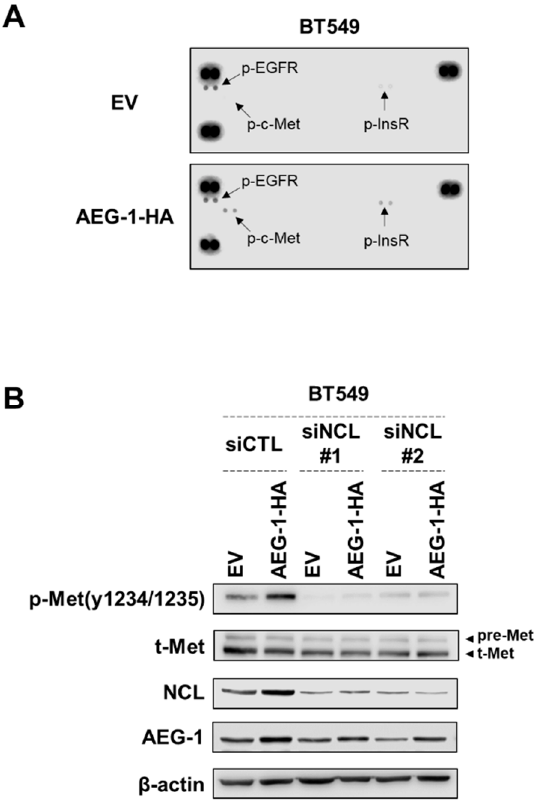
Figure 4. AEG-1 promotes c-Met activating tyrosine phosphorylation and NCL knockdown reduces AEG-1-induced c-Met activation in breast cancer cells. ( A ) BT549 cells were transfected with the AEG-1-HA or empty vector (EV) plasmids. The global tyrosine phosphorylation of receptor tyrosine kinases was then analyzed by Human Phospho-Receptor Tyrosine Kinase (RTK) Array Kit. ( B ) BT549 cells were transfected with the indicated siRNAs, then AEG-1-HA or empty vector plasmids were transfected two days later. Cell lysates were subjected to western blotting with the indicated anti- bodies. Representative data from three independent experiments with similar results are